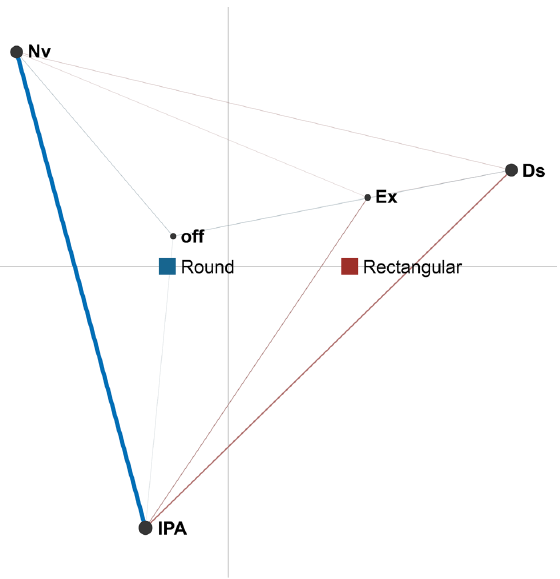
Figure 4. Difference network for dyads under two conditions (round and rectangular tables).